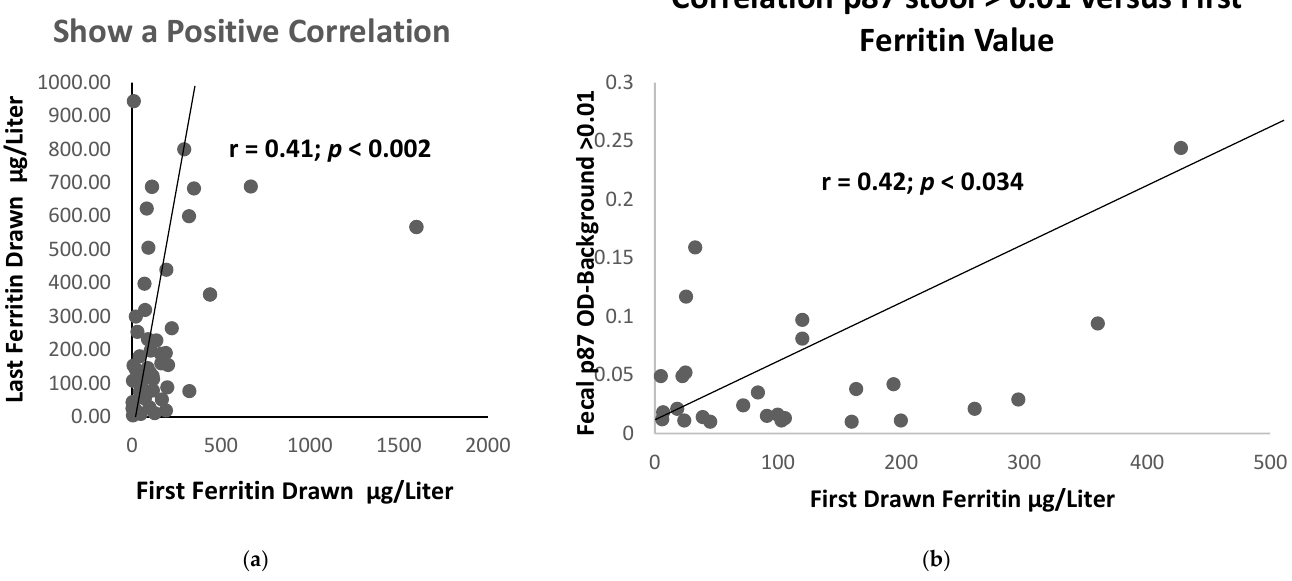
Figure 3. Correlation of paired ferritin levels, initial and last drawn in 56 patients ( a ), and a scatter- gram of 27 pairs ( b ) of initial ferritin, plotted against Stool bound Adnab-9 binding > 0.01 showing a positive correlation between stool p87 and initial ferritin values.